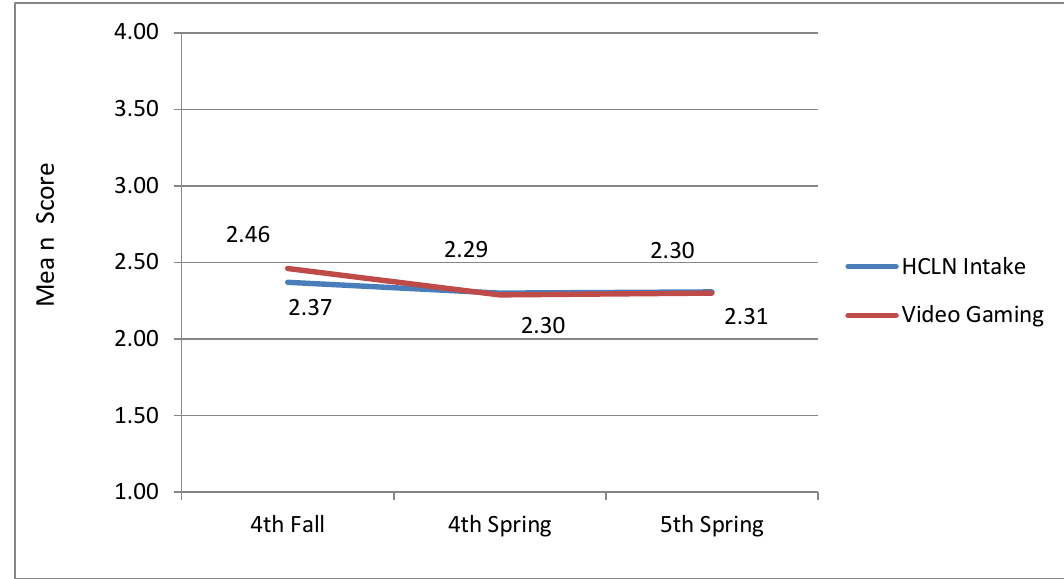
Figure 1. Co-occurrence and growth in HCLN and video gaming.